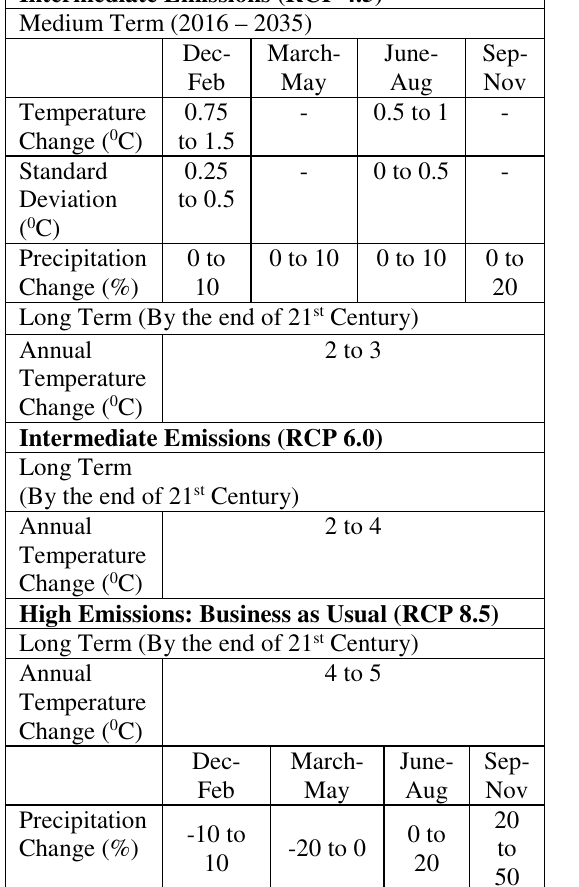
Table 2: Projections of Temperature and Precipitation for Sindh Intermediate Emissions (RCP 4.5)